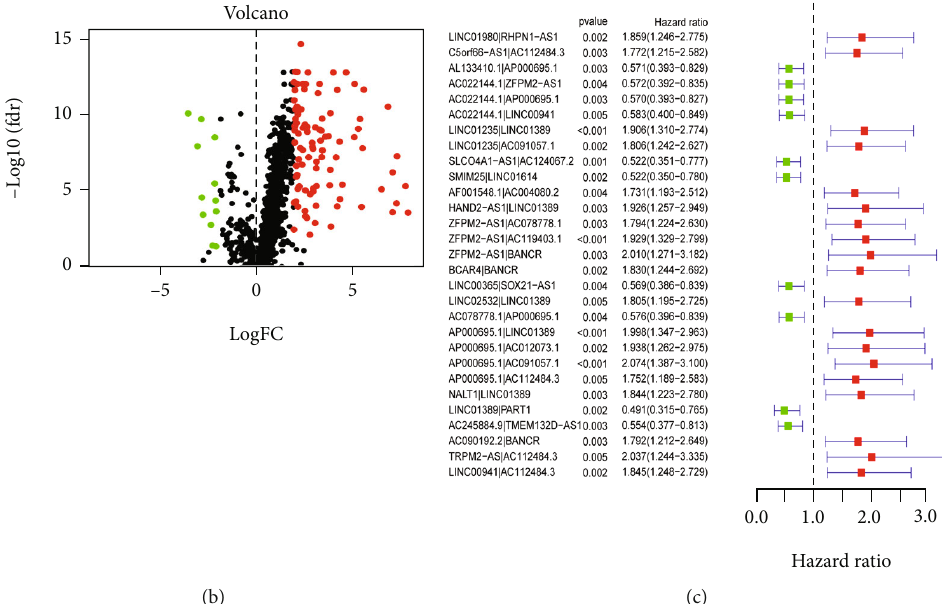
Figure 2: DEirlncRNAs were identi fi ed to obtain prognosis-related irlncRNAs. Heatmap was used to visualize the expression of DEirlncRNAs (a). Volcano map was utilized to visualize upregulated and downregulated DEirlncRNAs (b). Univariate analysis was performed to identify prognosis-related DEirlncRNA pairs